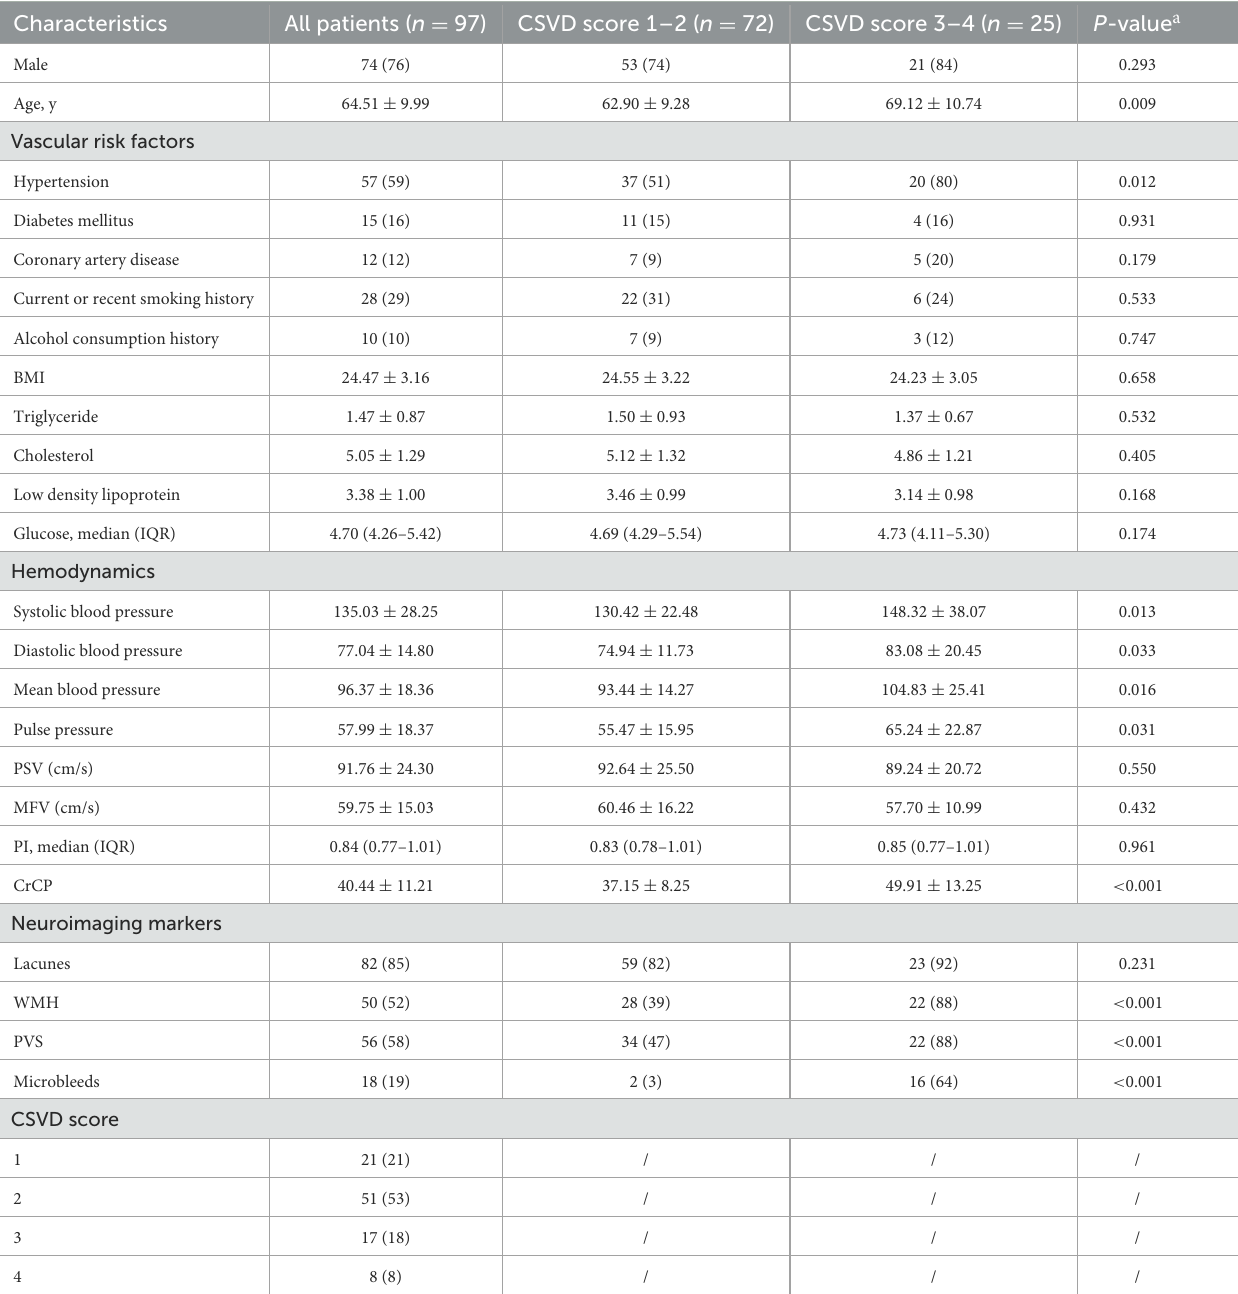
TABLE 1 Demographics and baseline characteristics of participants by CSVD